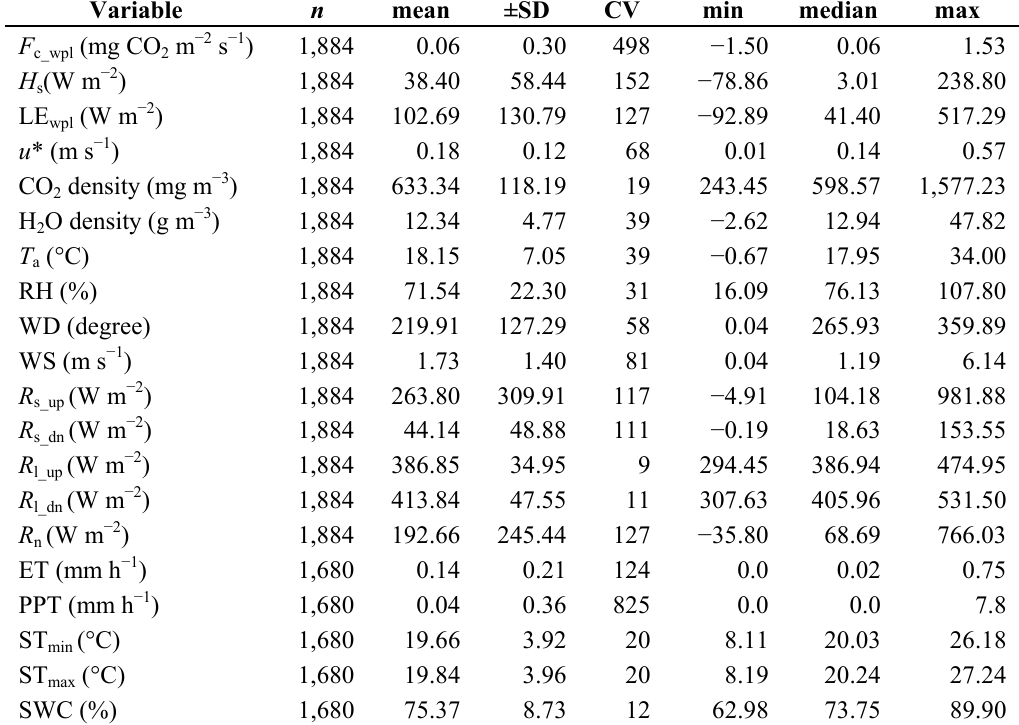
Table 1. Descriptive statistics of eddy covariance and meteorological data collected on an hourly basis in the Yenicaga peatland.